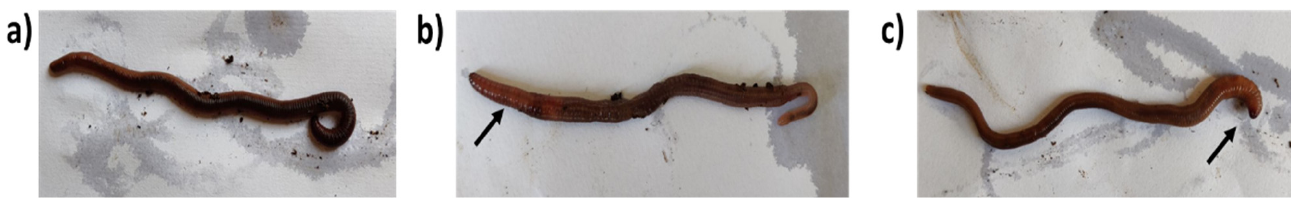
Table 3. Phenotypic changes observed in zebrafish exposed to silver nanoparticles synthesized us-